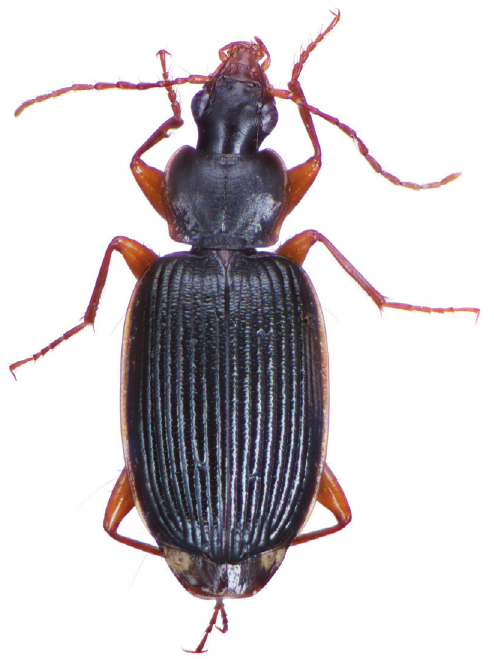
Figure 9. Dorsal habitus and color pattern of Amphimenes carinacaulis sp. n .. (OBL 7.35 mm). Hind wings .